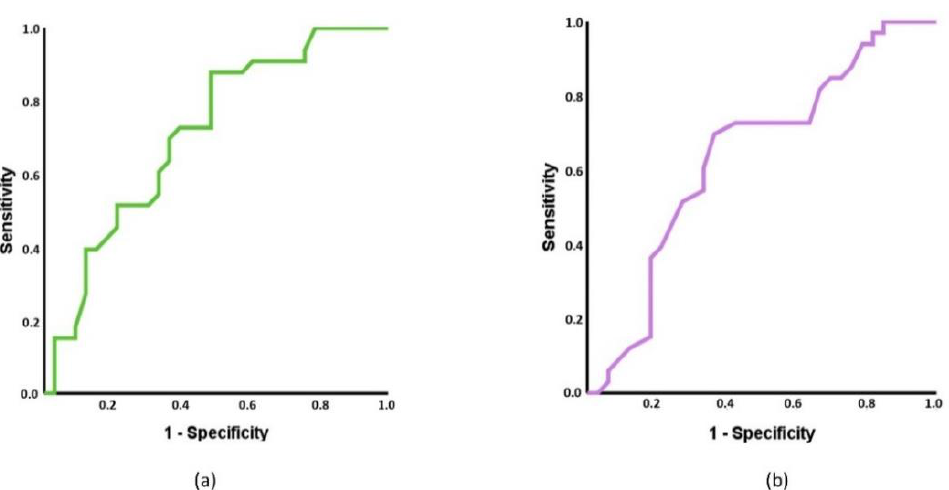
Figure 3. Receiver operating characteristic (ROC) curve of the cervical decrement ( a ) and lumbar flexion ( b ), to discriminate between individuals with acute low back pain and controls. ( a ) Area under the curve (AUC): for cervical decrement = 0.709 (95% confidence interval (CI) = 0.584–0.835). ( b ) AUC: lumbar flexion = 0.660 (95%CI = 0.524–0.791).